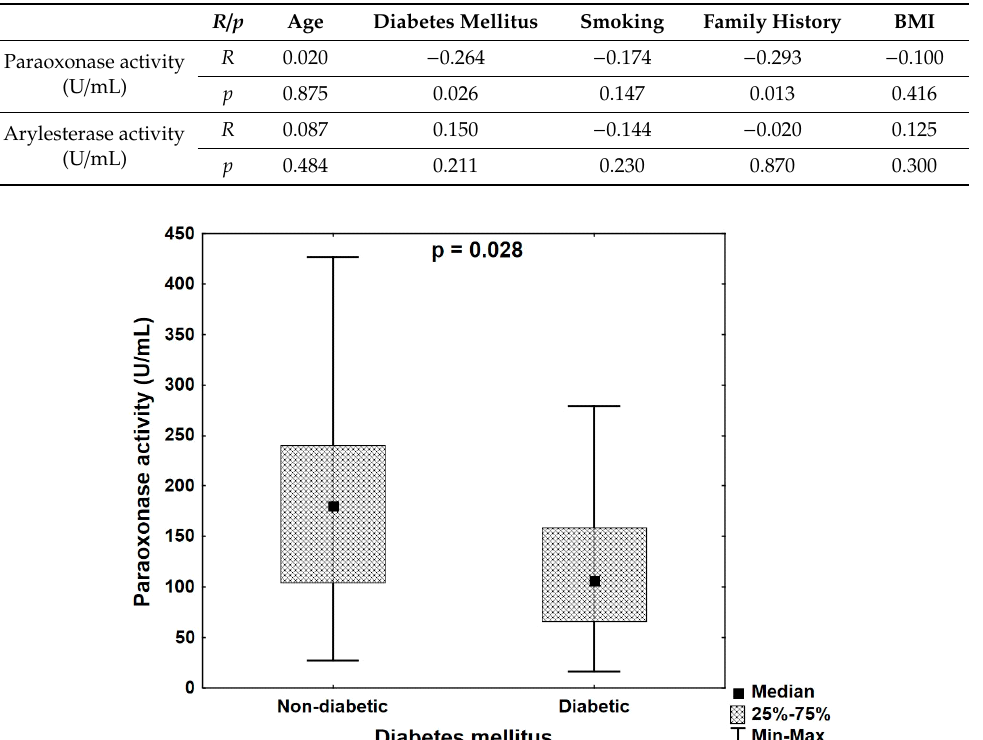
Table 2. Correlation of serum paraoxonase activity and risk factors of coronary heart disease in group of patients ( R , correlation coefficient; p , value according to Spearman test).